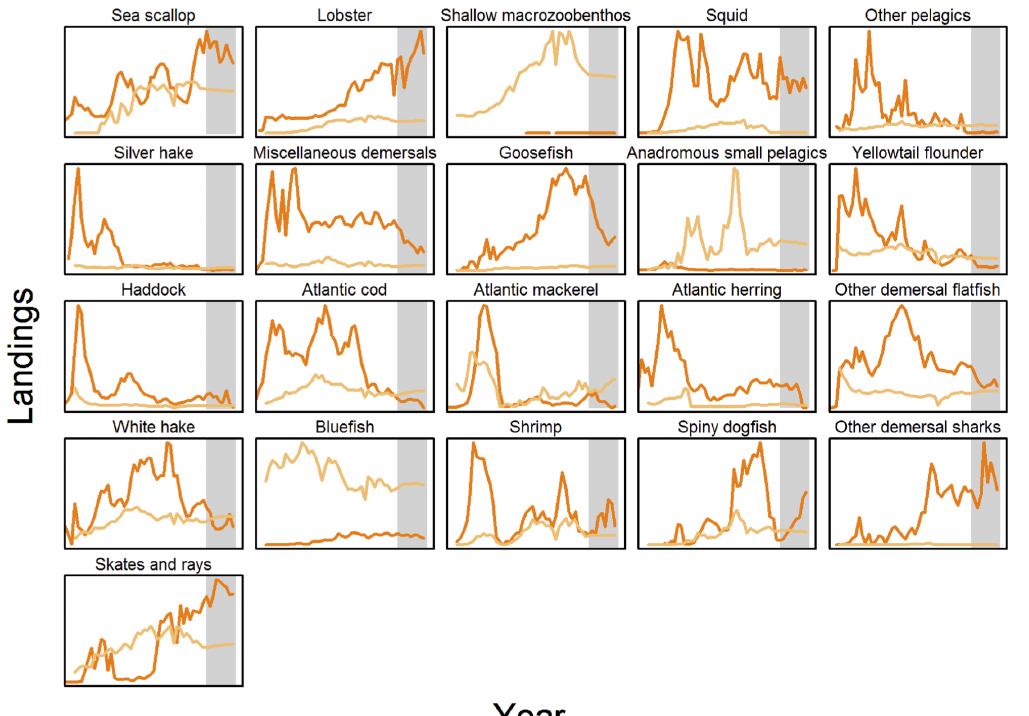
Fig 4. Landings (normalized) time series. Recorded (actual) landings (dark orange) versus Atlantis model catch predictions (light orange). Gray area indicates the forecast time-period from 2004 –